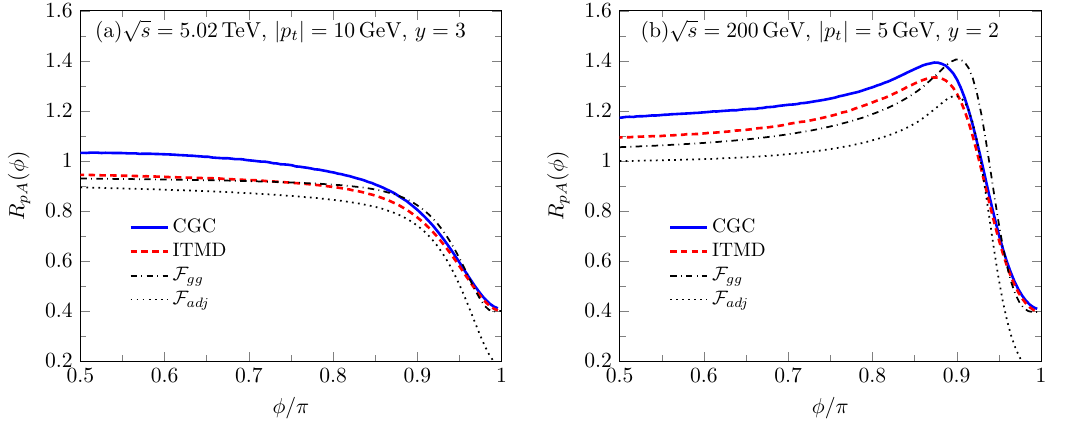
Figure 12 . (a): R pA obtained in the CGC (blue solid), ITMD (red dense dashed) formulas for q ¯ q dijet production with | p t | = 10 GeV and y = 3 in p + A collisions ( ˆ c = 2 . 5 ) at comparion, R pA of the gluon TMDs with ˆ c = 2 . 5 to those with ˆ c = 1 , devided by ˆ c = 2 . 5 , is shown for F gg (black dash-dotted) and F adj (black dotted). (b): the same with | p t | = 5 GeV and y = 2 at √ s = 200